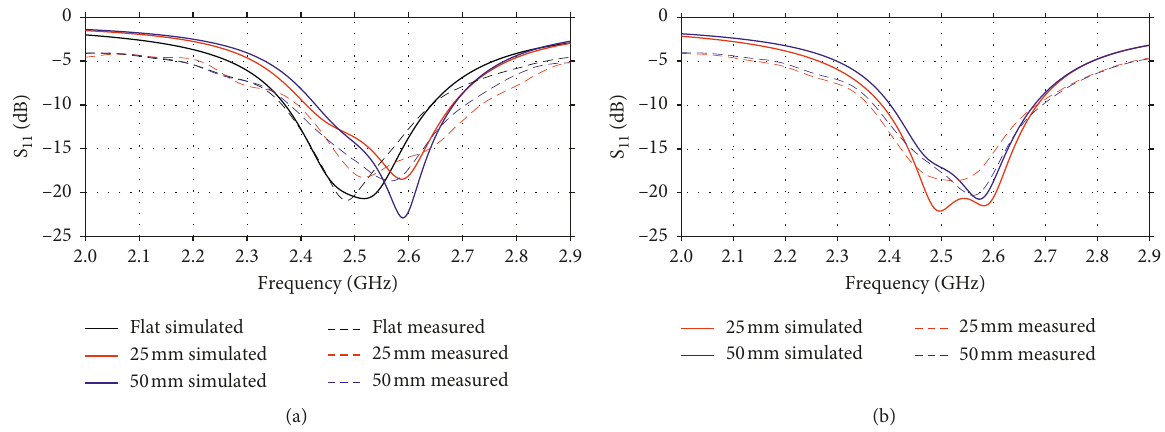
Figure 6: Simulated and measured S 11 curves with different radii. (a) Bending along the x -axis. (b) Bending along the y -axis.